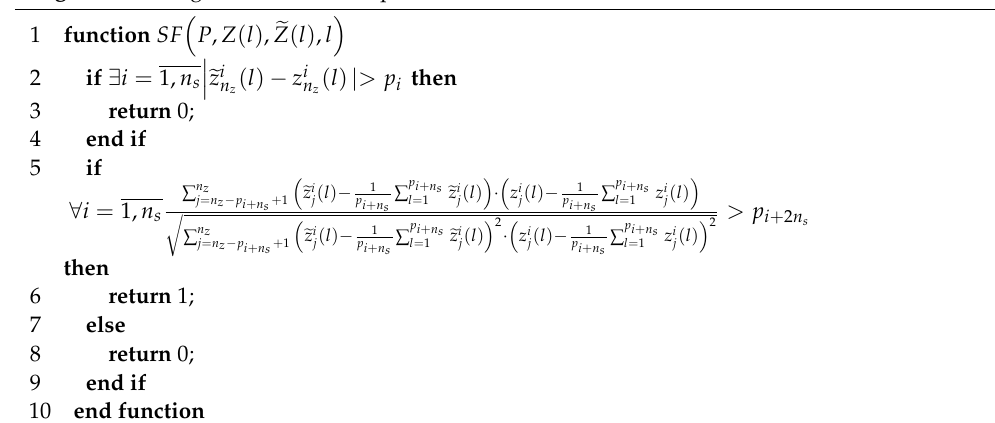
Algorithm 1. Algorithm of the SF operation.